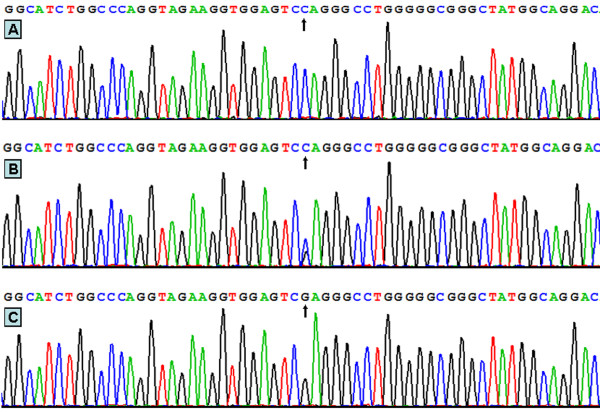
A part of the nucleotide sequence of rs2072183 SNP. (A) CC genotype; (B) CG genotype; (C) GG genotype.